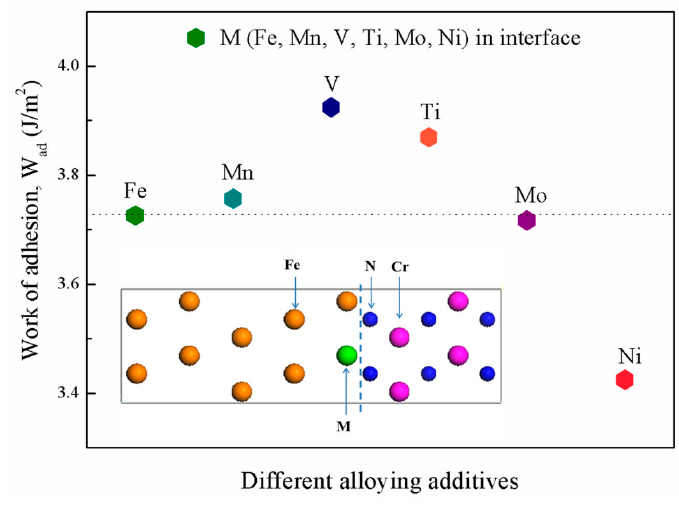
Figure 3. The work of adhension ( W ad ) for the clean Fe(111)/Cr 2 N(0001) interface and that after M (M = Mn, V, Ti, Mo, Ni) atom introduced.